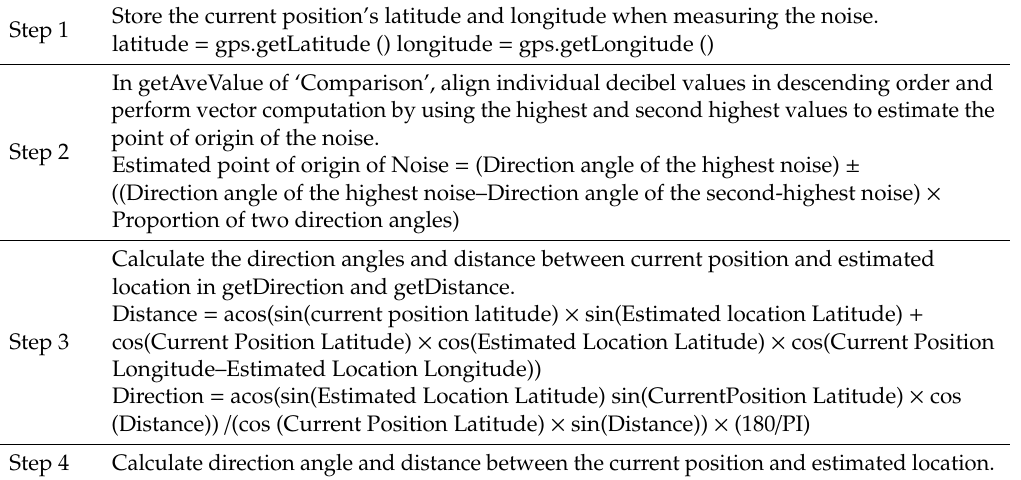
Table 3. The direction estimating algorithm.